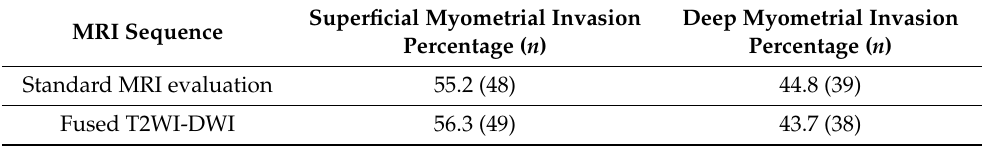
Table 2. MRI evaluation of endometrial invasion.